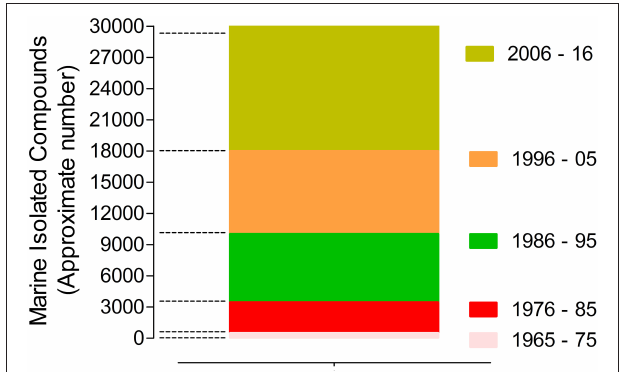
FIGURE 1 | Marine compounds isolated in the last 50 years (approximate number/10 years) (Faulkner, 1984, 1986, 1987, 1988, 1990, 1991,